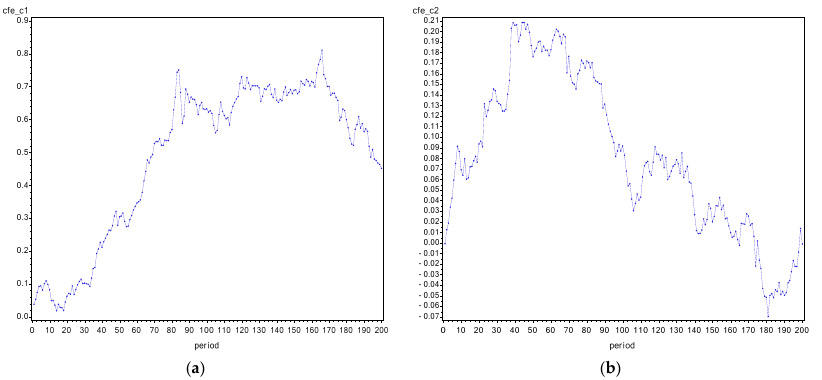
Figure 2. Calculated CFE graph. The actual figures after the focal episode are subtracted by the forecasts via the MLE procedure. ( a ) The first focal episode on 10 January 2014; ( b ) the second focal episode on 8 July 2019. Figures imply that the impact of the Indonesian export ban in 2014 is relatively larger than that of in 2019.